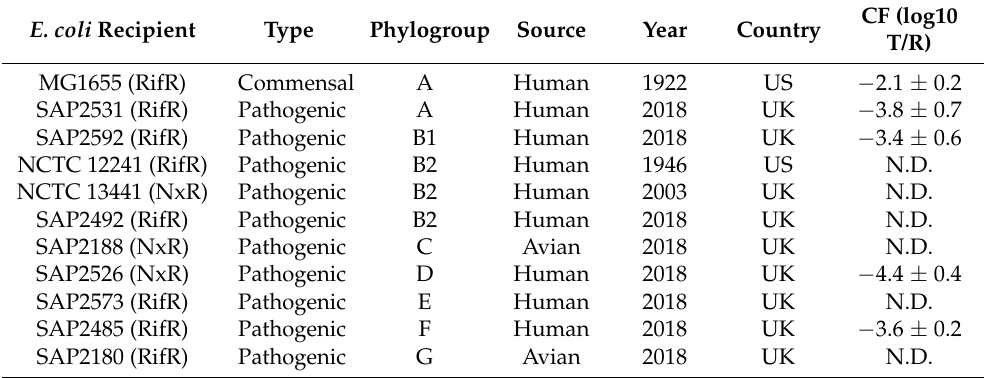
Table 1. Pathogenic and commensal E. coli isolates used as recipients in conjugation